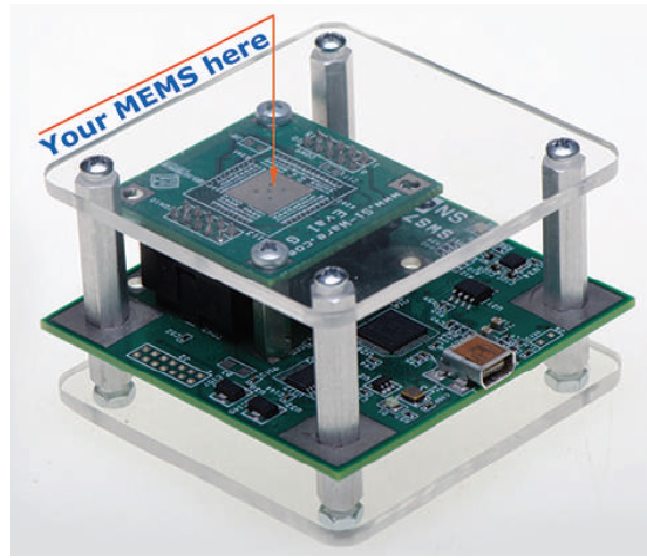
Figure 2. Schematic view of the specialized SWS61111 platform.